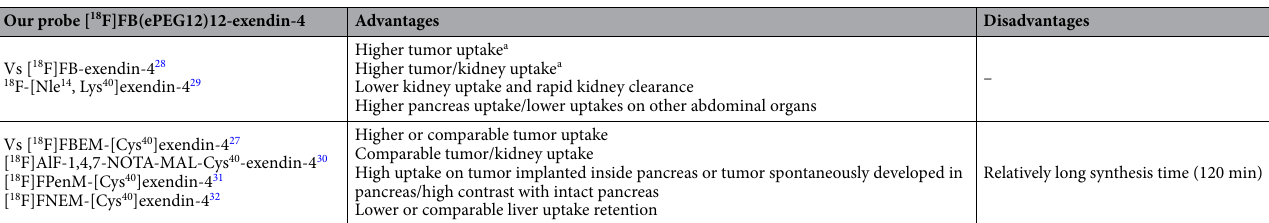
Table 3. The advantages and disadvantages of [ 18 F]FB(ePEG12)12-exendin-4 in comparison with other representative non-PEGylated probes. a The comparison was performed with [ 18 F]FB-exendin-4. The data regarding tumor uptakes of 18 F-[Nle 14 , Lys 40 ]exendin-4 is not